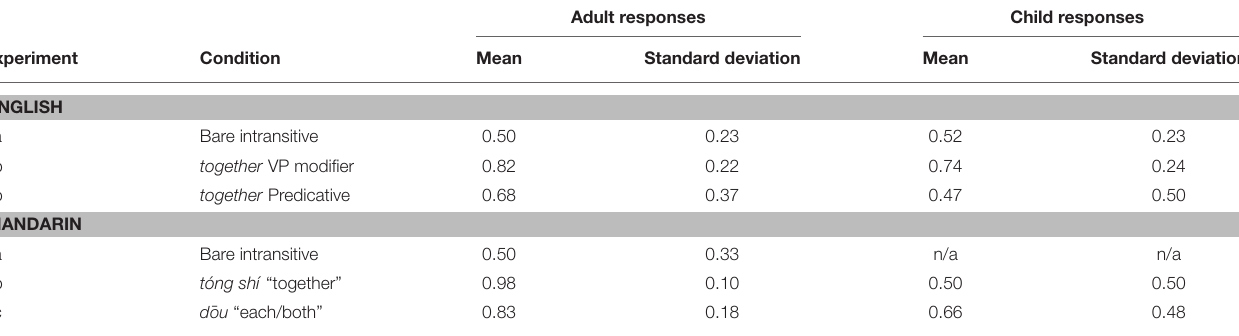
TABLE 3 | Summary of participant responses (proportion of selection of Synchronous scene) across all experiments.